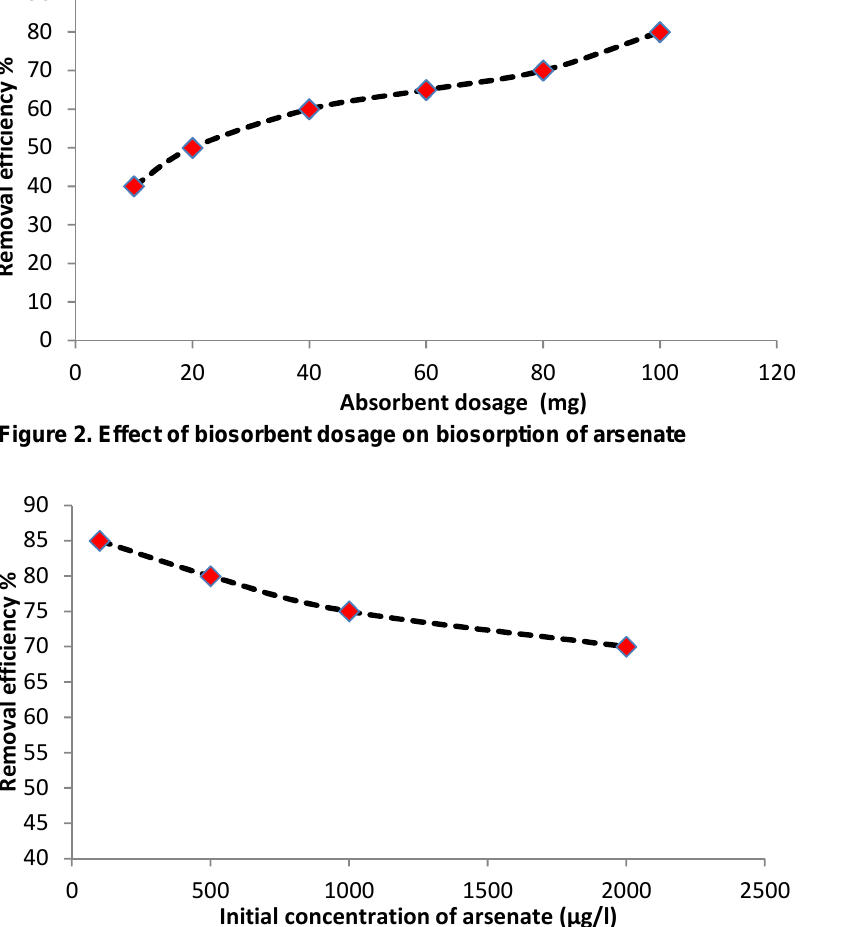
Figure 3. Effect of metal ion concentration on the biosorption of arsenate by